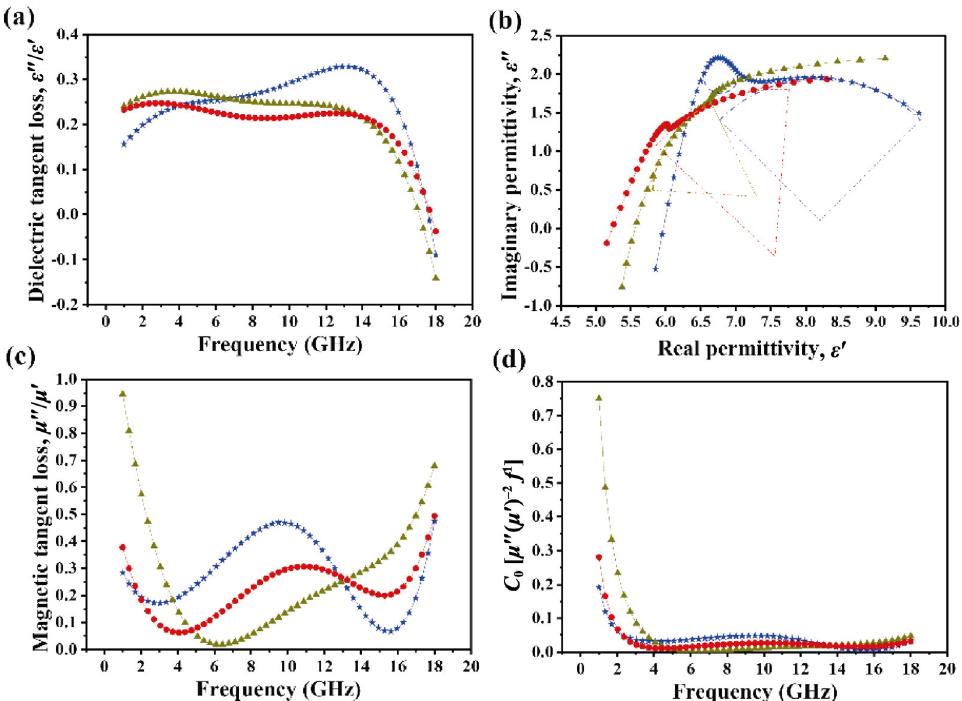
Fig. 8 (a) Frequency dependences of dielectric tangent loss ( ε″ / ε′ ), (b) Cole–Cole semicircles, (c) magnetic tangent loss ( μ″ / μ′ ), and (d) C 0 –f curves of HE MFe 2 O 4